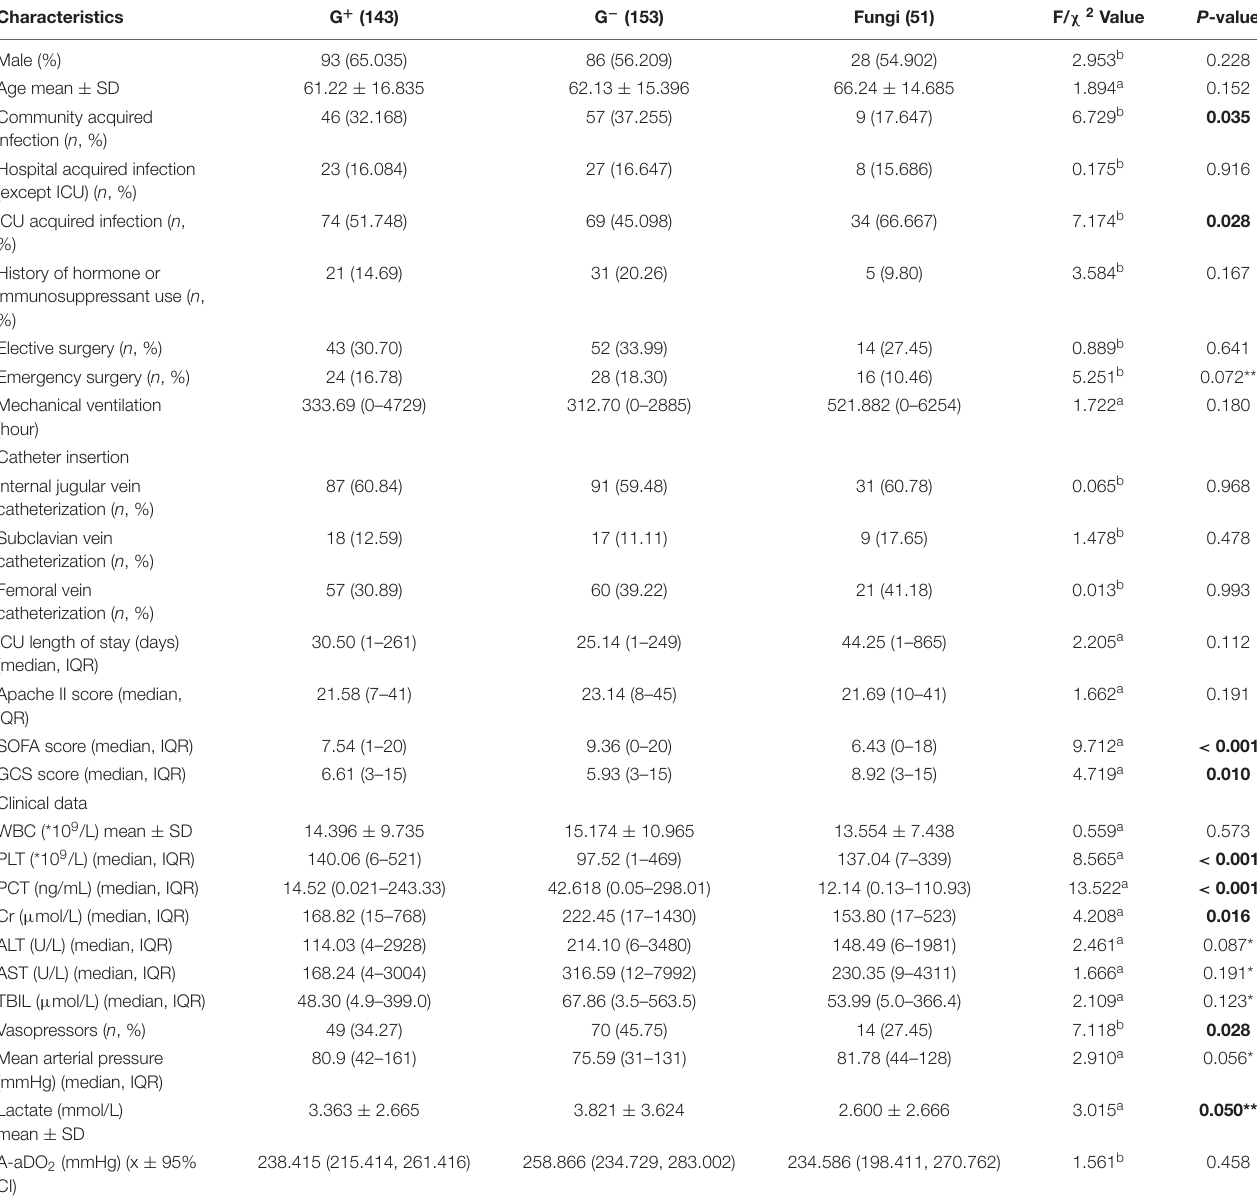
TABLE 1 | The characteristics of the included patients, except for one case with more than one strain.